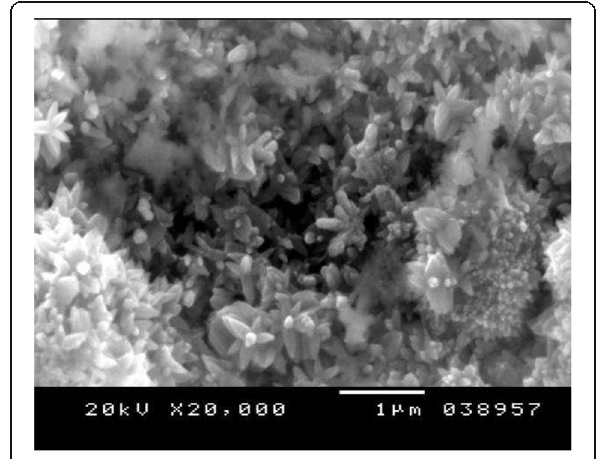
Fig. 8 Scanning electron microphotograph of control Cp titanium specimen at ×10,000